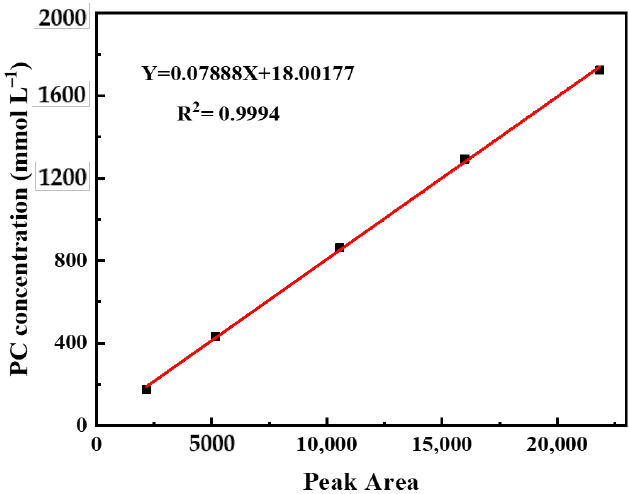
Figure 1. Standard curve of peak area versus PC concentration.